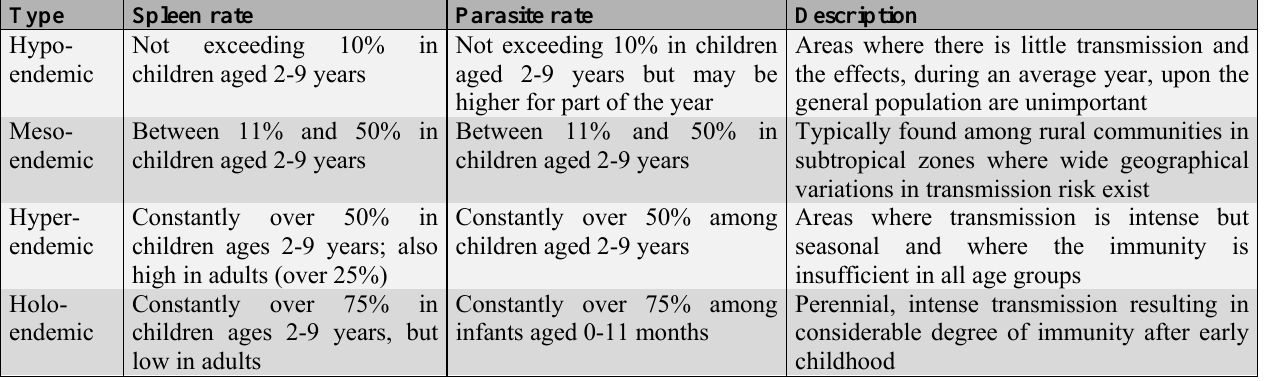
Table 2. Classification of endemic malaria (reference